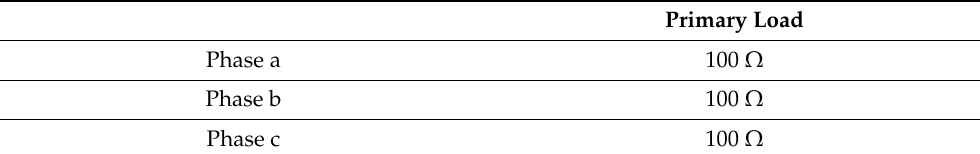
Table 3. Symmetric Resistive Load Parameters.